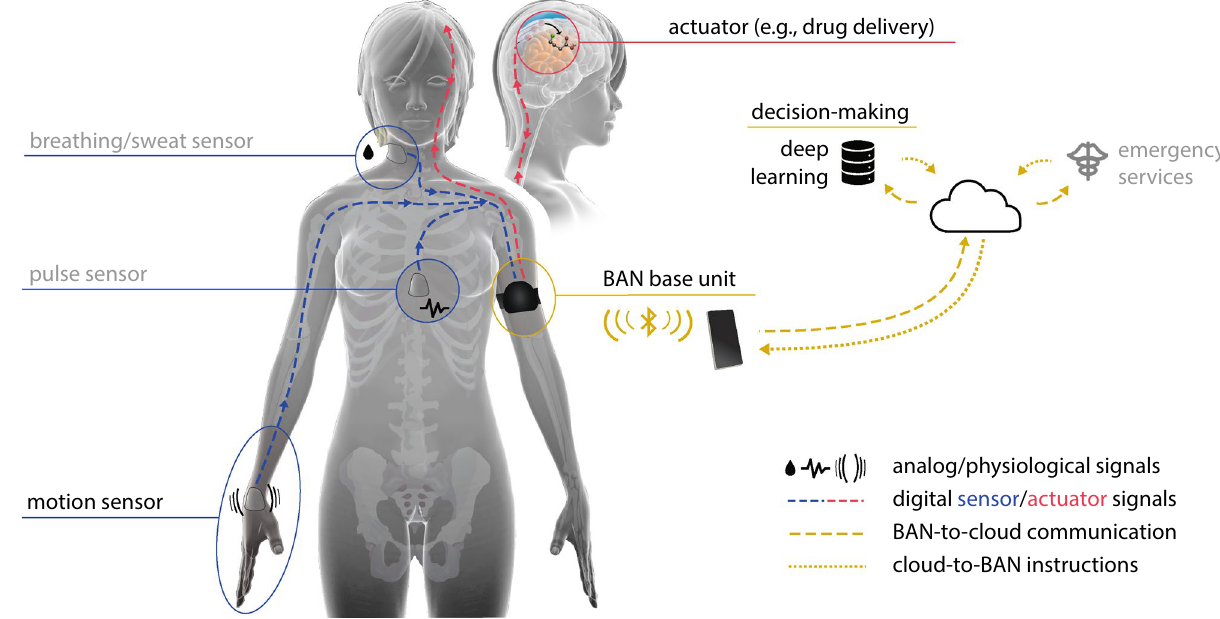
Figure 1. The digital nervous system (DNS), a smart healthcare body-area network (BAN). Separate nodes on the human body work in unison to sense and communicate health parameters and actuate medical treatments. Sensor nodes (e.g., breathing/sweat, pulse, motion) convert physiological information into digital signals which are wirelessly relayed to a central decision-making base unit, and actuator nodes, exemplified by an implantable drug delivery device, convert digital signals into biochemical fluxes. Data transferred from the BAN to cloud data handling services can be utilized for direct contact with care providers or emergency services, as well as decision making, analysis, and improved treatment schemes (which can be relayed back to the BAN). The features labeled in black are included in the DNS proof-of-concept while greyed-out features are meant to illustrate the broader vision for the DNS platform. X-ray illustrations adapted from SciePro/Shutterstock with